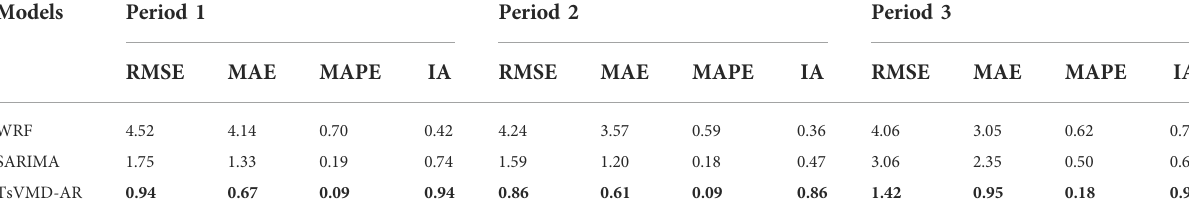
Values in bold means the best performance of all